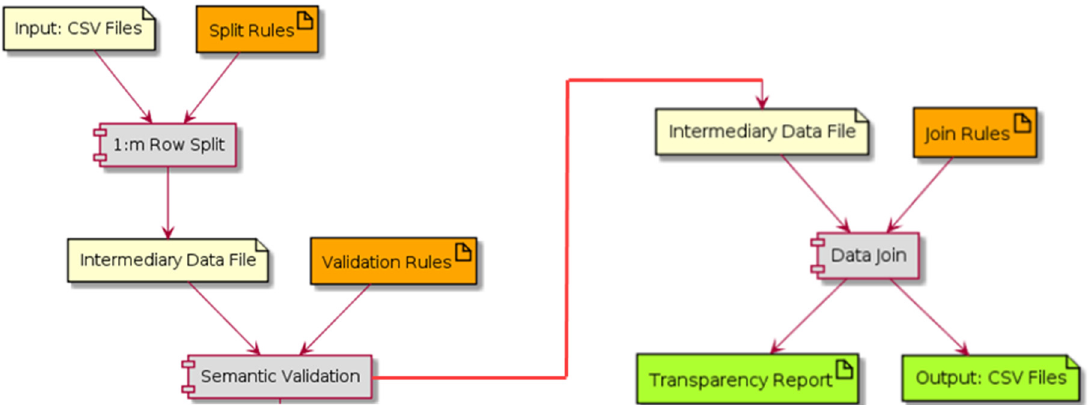
Figure 4. Detail of the Transform phase of the proposed (E3TL) approach that is applied to comma- separated values (CSV) input fi